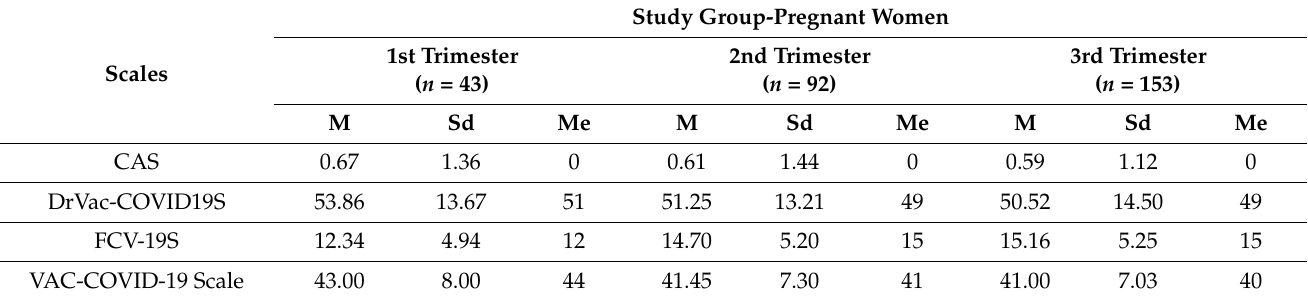
Table 5. Correlations between scores and pregnancy trimester.